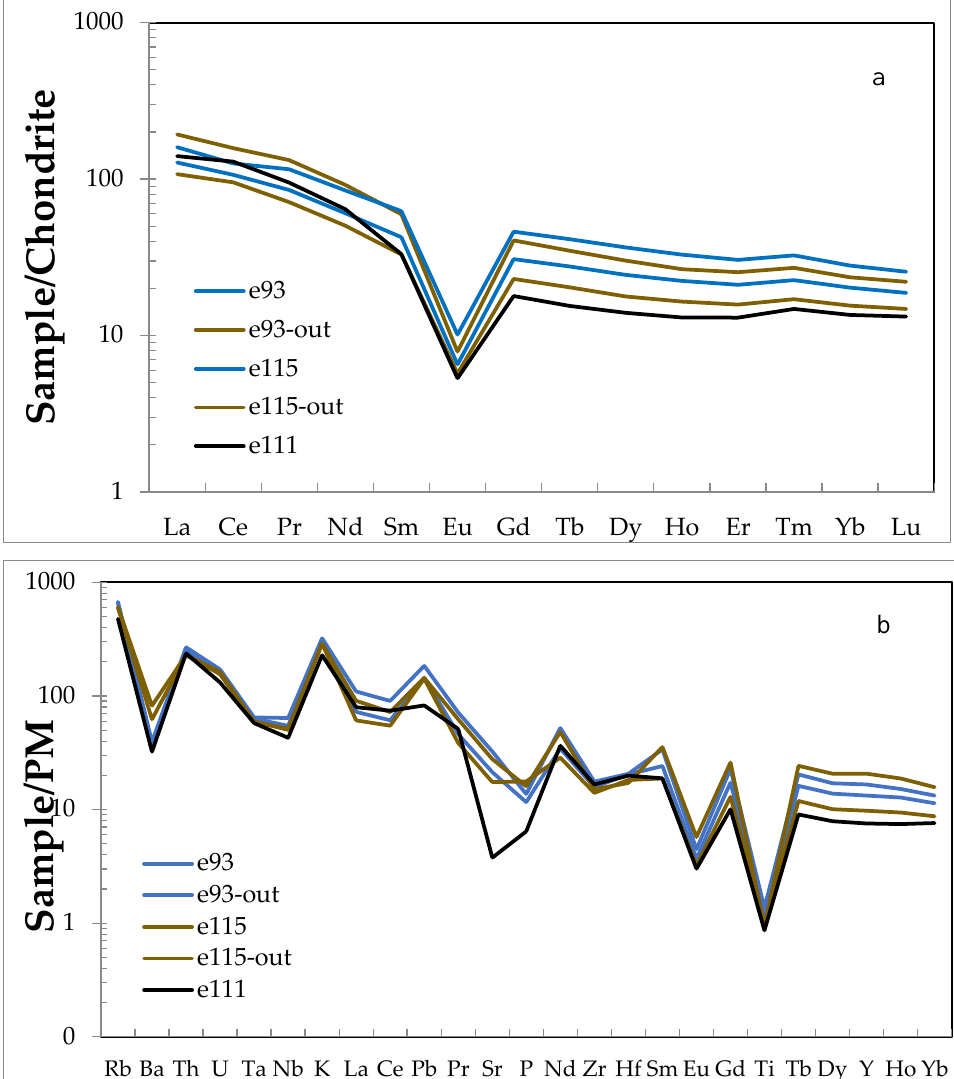
Figure 10. ( a ) REE chondrite normalized plot. ( b ) Trace elements primitive mantle-normalized plot.